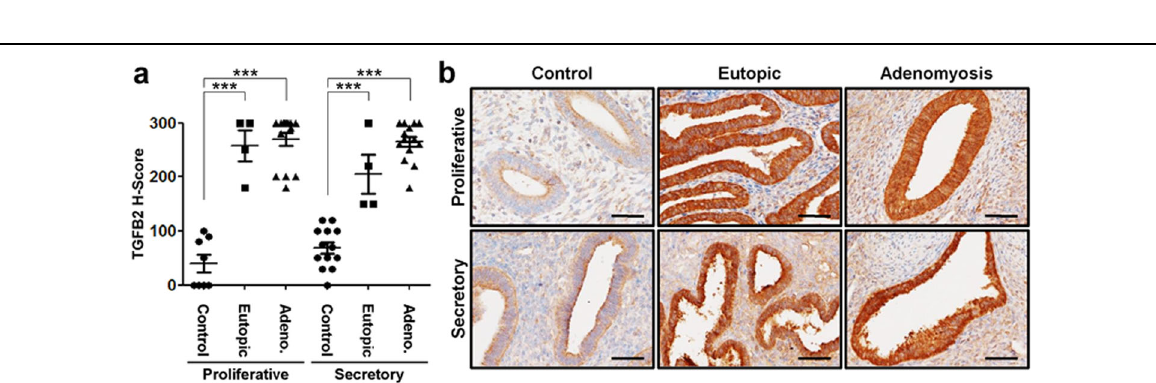
Fig. 3 Overexpression of TGF- β 2 in eutopic endometrium and adenomyotic lesions from women with adenomyosis. a Semiquantitative analysis of TGF- β 2 levels in control endometrium from the proliferative ( n = 8) and secretory ( n = 13) phases and eutopic endometrium ( n = 4 per phase) and adenomyotic lesions ( n = 15 per phase) from the proliferative and secretory phases with adenomyosis analyzed by immunohistochemical H-score. The results represent the mean ± SEM. *** p < 0.001. b Representative photomicrographs of immunohistochemical staining of TGF- β 2 in women endometrium with (eutopic and adenomyostic lesions) and without adenomyosis during the proliferative and secretory phases. Controls represent the endometrium from women with no history or evidence of adenomyosis. Eutopic refers to the endometrium, and adenomyosis refers to lesions from women with adenomyosis. Scale bars represent 50 μ